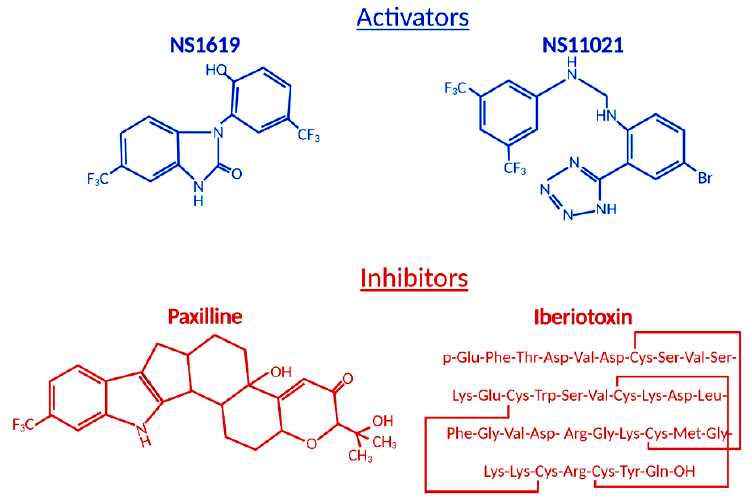
Figure 2. Structural formulas of commonly used mitochondrial BK Ca modulators.